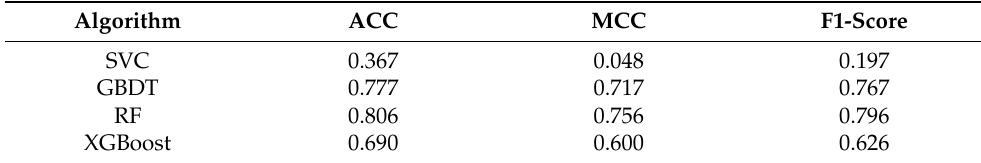
Table 4. Classification results of spatial groups on the four ML test sets.